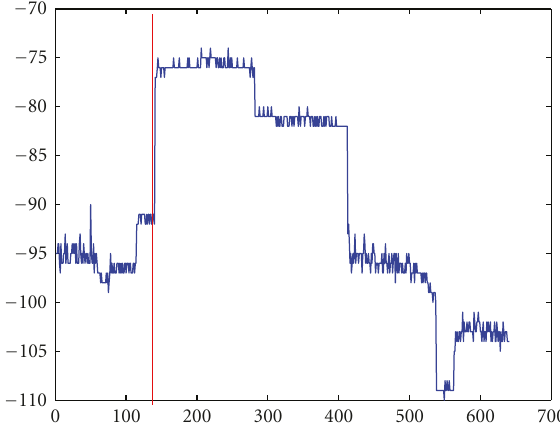
Figure 3: Transient detection from a signal generated by a Bluetooth